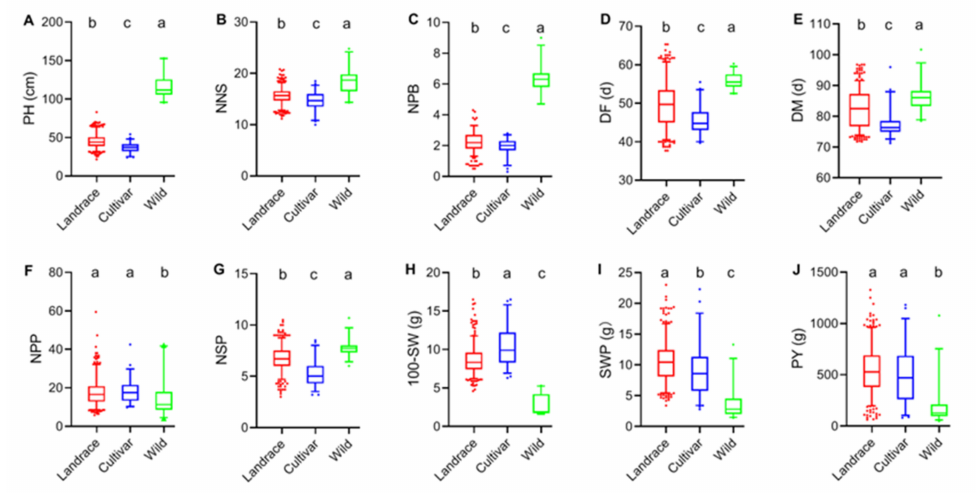
Figure 2. Box and bar plots of plant height ( A ), nodes number of the main stem ( B ), number of plant branches ( C ), days to flowering ( D ), days to maturity ( E ), number of pods per plant ( F ), number of seeds per pod ( G ), 100-seed weight ( H ), seeds weight per plant ( I ), and plot yield ( J ) grouped by species, in each box and bar plot the respective groups were compared using a least significant difference (LSD) test and the groups with the different letters were significantly different at alpha = 0.05. Different colors of bar represent different germplasm types. Red, blue, and green color represent landraces, cultivated varieties, and wild accessions,